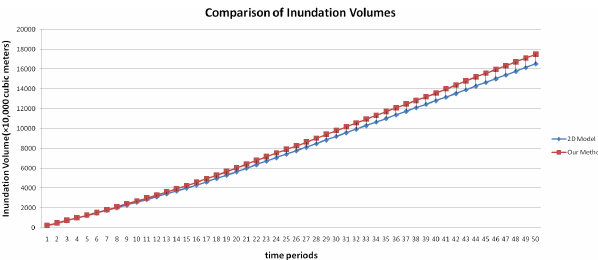
Figure 12. Comparison of inundation areas during different time periods. Figure 13. Comparison of inundation volumes during different time